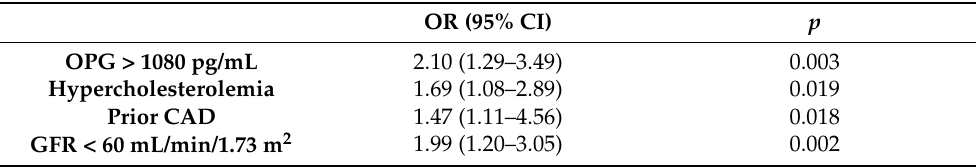
Table 3. Multivariate logistic regression analysis for the prediction of CAD extent (last SYNTAX Tertile) (OR: odds ratio; CI: confidence